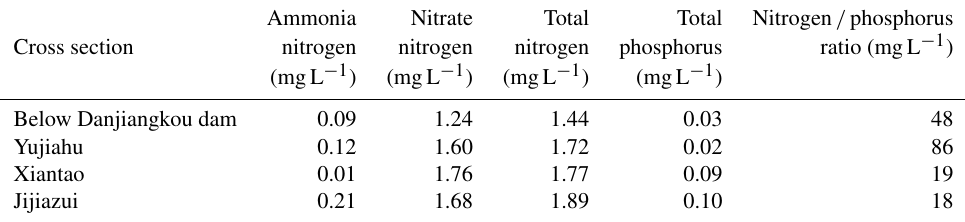
Table 1. Monitoring results of nutritional salts of some cross sections in the middle and lower reaches of Hanjiang River during February. Ammonia Nitrate Total Total Nitrogen / phosphorus Cross section nitrogen nitrogen